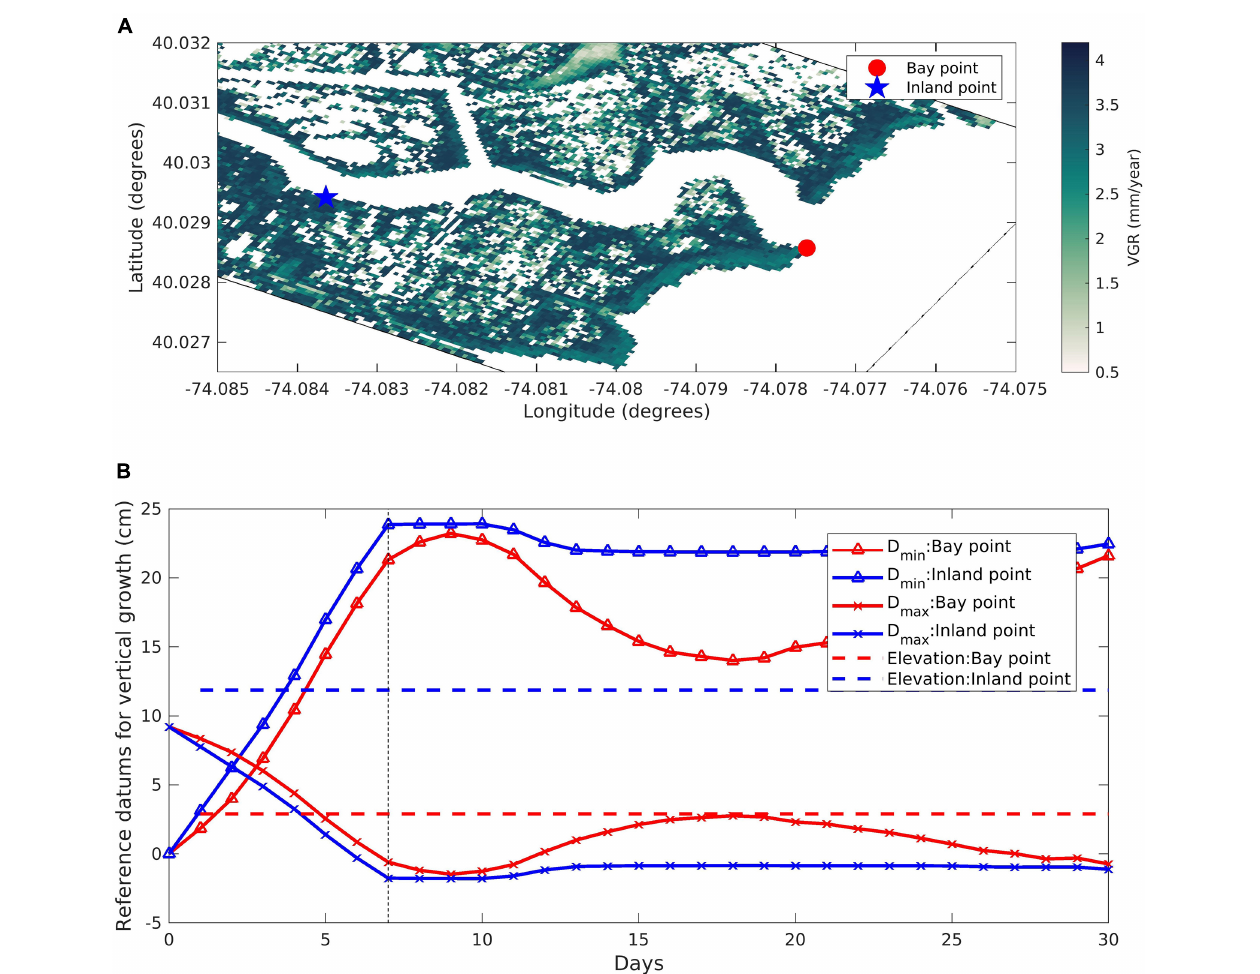
FIGURE 10 | (A) Zoomed in Reedy Creek domain showing the colormap of vertical growth rate (VGR) due to biomass productivity at the end of the simulation with the location of bay (red circles) and inland points (blue star), with (B) time series of reference datums for vertical growth rate at Bay and Inland